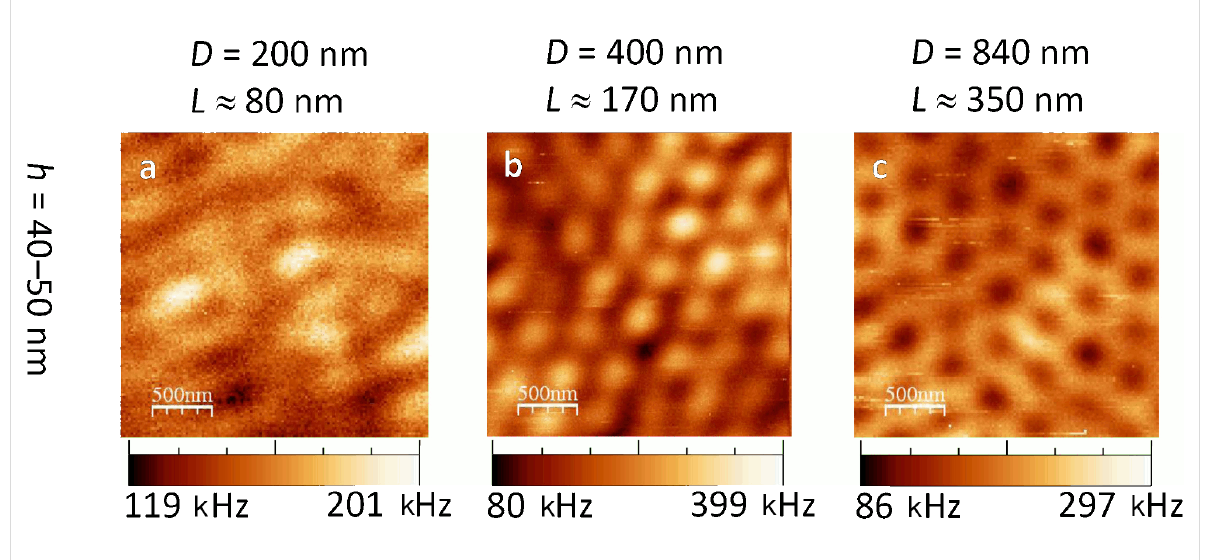
Figure 5: Confocal luminescence patterns of gold nano-triangles on glass excited by a radially polarised laser beam . In (a) and (b) the height of the triangles was h = 40 nm, whereas in (c) it was h = 50 nm.